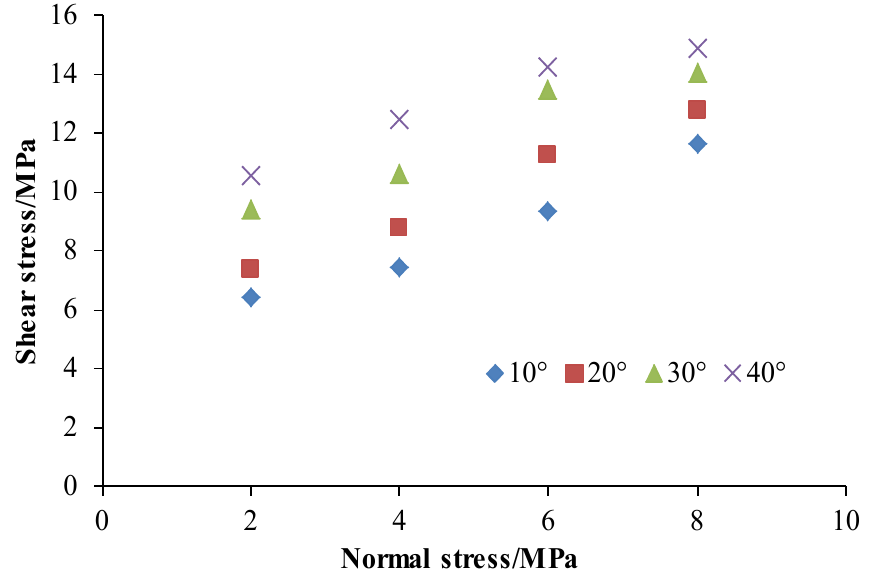
Figure 9. Relationship between normal stress and peak shear stress with different undulating angles at a 0.6 mm/min shear rate.